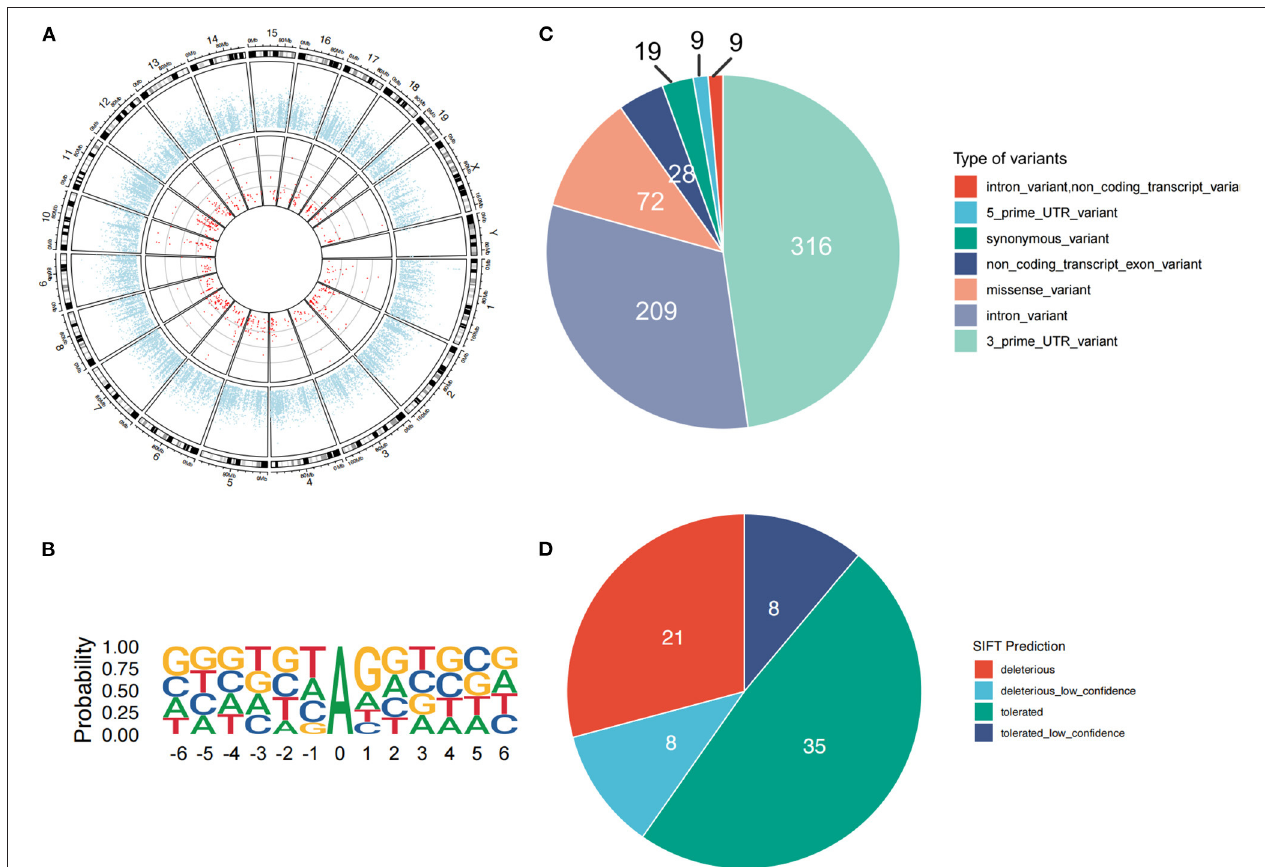
FIGURE 1 | A-to-I RNA editing sites identified from the dorsal striatal transcriptome of male adult mice. (A) The red dots denote individual high-confidence editing sites. The blue dots show the mean expression levels of individual genes. (B) The motif of sequence context surrounding the A-to-I RNA editing sites. Six nucleotides upstream and downstream of the editing sites are shown. (C) Functional categories of various types of the A-to-I RNA editing sites. (D) About half of these missense events are predicted by SIFT to possibly be deleterious to the encoded